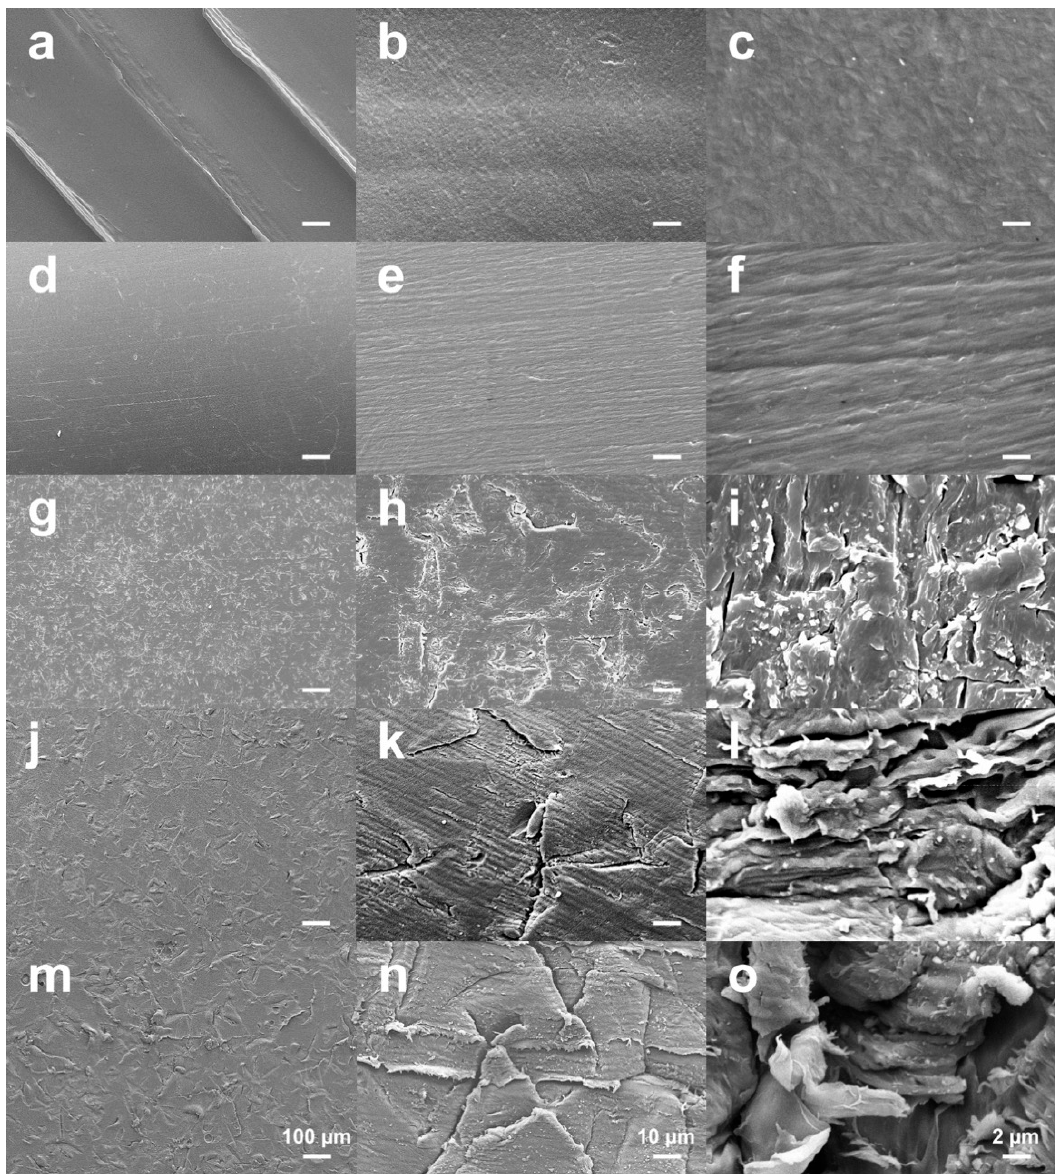
Figure 1. SEM images of the FFF 3D printed PEEK sample surfaces in different groups: ( a – c ) untreated; ( d – f ) polished; ( g – i ) grit-blasted (50 µm); ( j – l ) grit-blasted (120 µm); ( m – o ) grit-blasted (250 µm). Bars represent 100, 10, and 2 µm from left to right, respectively.